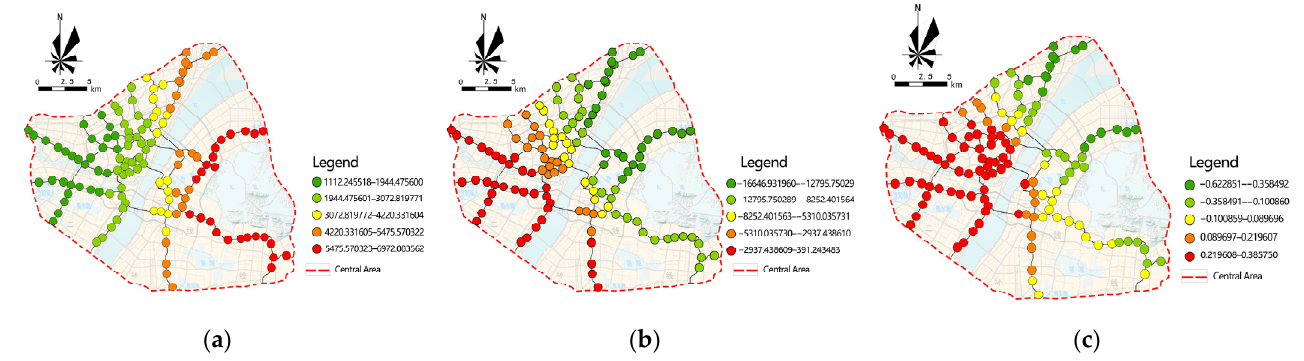
Figure 10. The spatial variation in the impact of significant variables on school-commuting distance. ( a ) whether station is a departure station regression coefficient; ( b ) mixed degree of land-use regression coefficient; ( c ) Road-density regression coefficient.